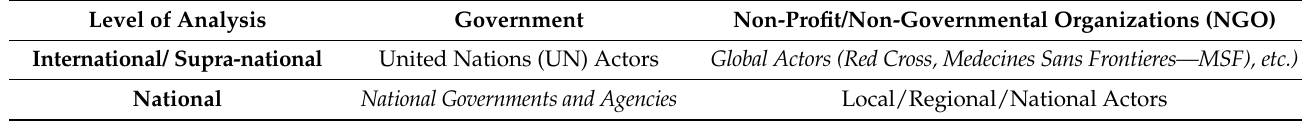
Table 1. Multiple actor levels in humanitarian